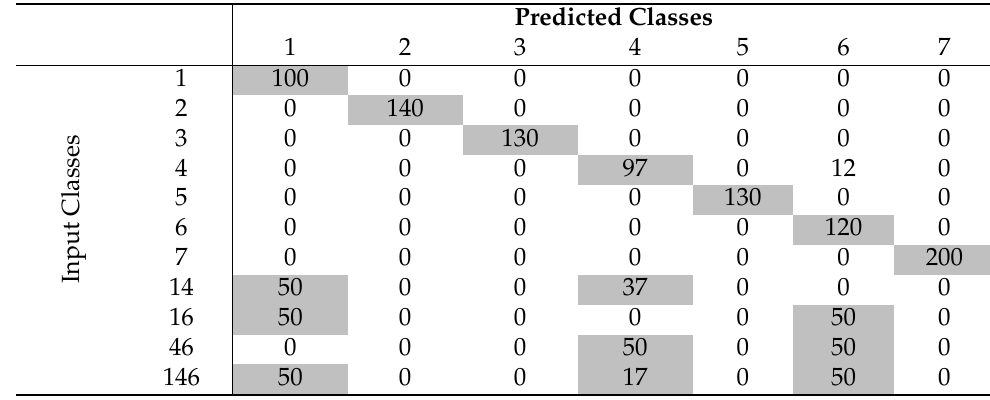
Table 8. Hybrid confusion matrix of the proposed